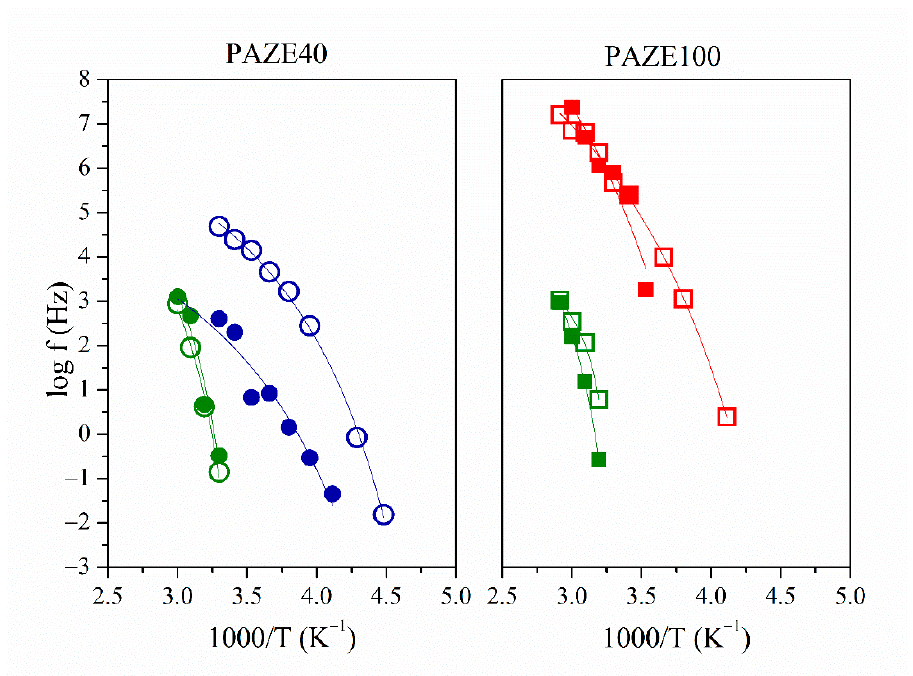
Figure 12. Detail of the Arrhenius maps of the γ relaxation of PAZE100 and PAZE40 for unoriented (full symbol) and oriented (hollow symbol) copolymers.